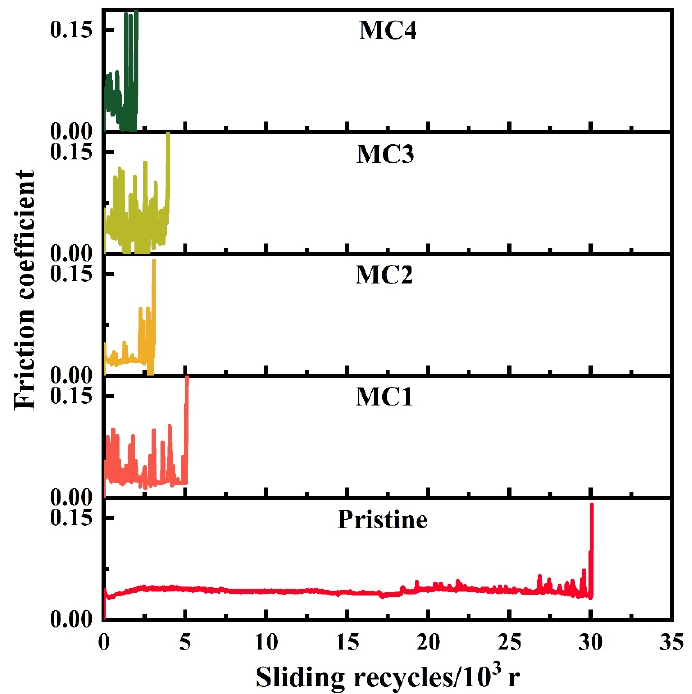
Figure 7. The wear lives of the multilayer films before and after irradiation.